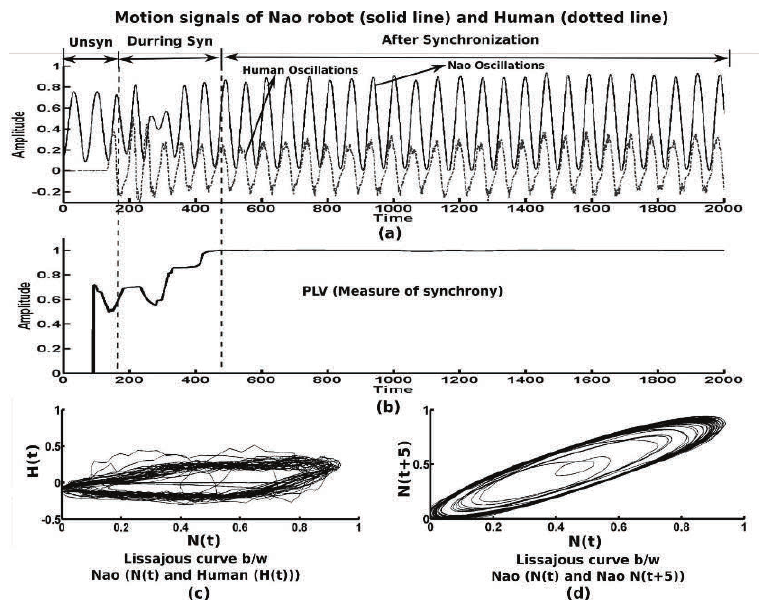
Figure 3. Robot (Nao)-Human interaction: (a) Motion signals of the human (dotted line) and the Nao’s modifiable oscillator (solid line). (b) PLV measurement. (c) Lissajous curve N ( t ) (Nao’ oscillation) and H ( t ) (Human’s movements). The elliptic shape of the curve indicates that both signals are almost identical. (d) Lissajous curve between two di(cid:636)erent time values of Nao ( N ( t ) and N ( t + 5) ).